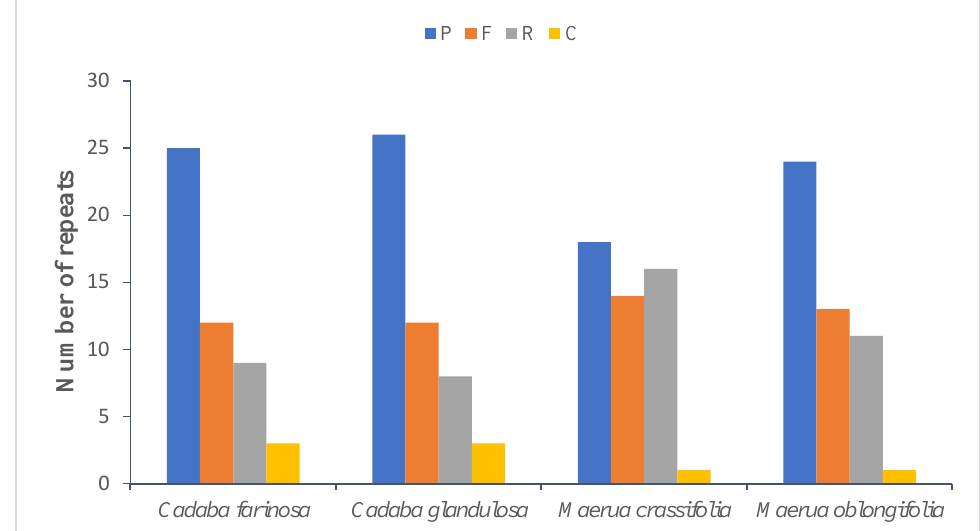
Figure 3. Number of different repeats in four chloroplast genomes of four species of Capparaceae. p = palindromic, F = forward, R = reverse and C= complement.